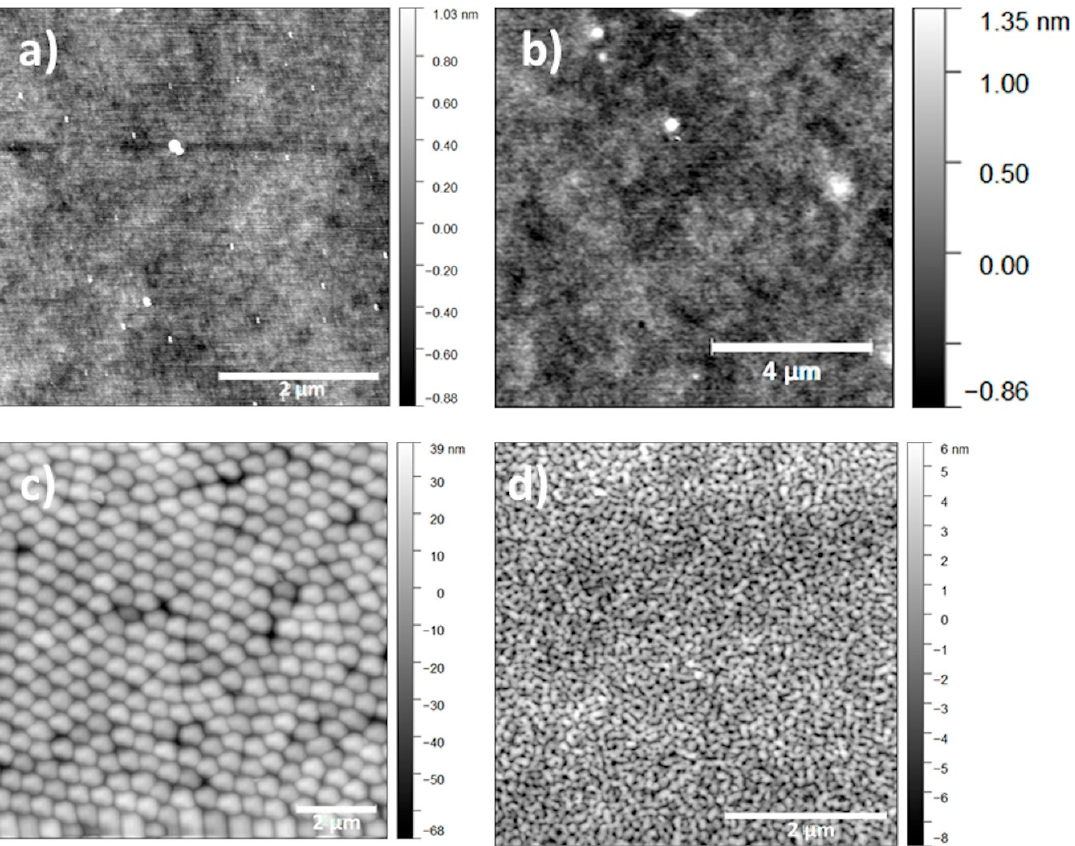
Figure 3. AFM images of ( a ) glass, ( b ) PNIPAm a , ( c ) PNIPAm b , and ( d ) IPN. Each film spin-coated on a glass-OH surface at a concentration of 3 wt% and speed R4 (5000 rpm).